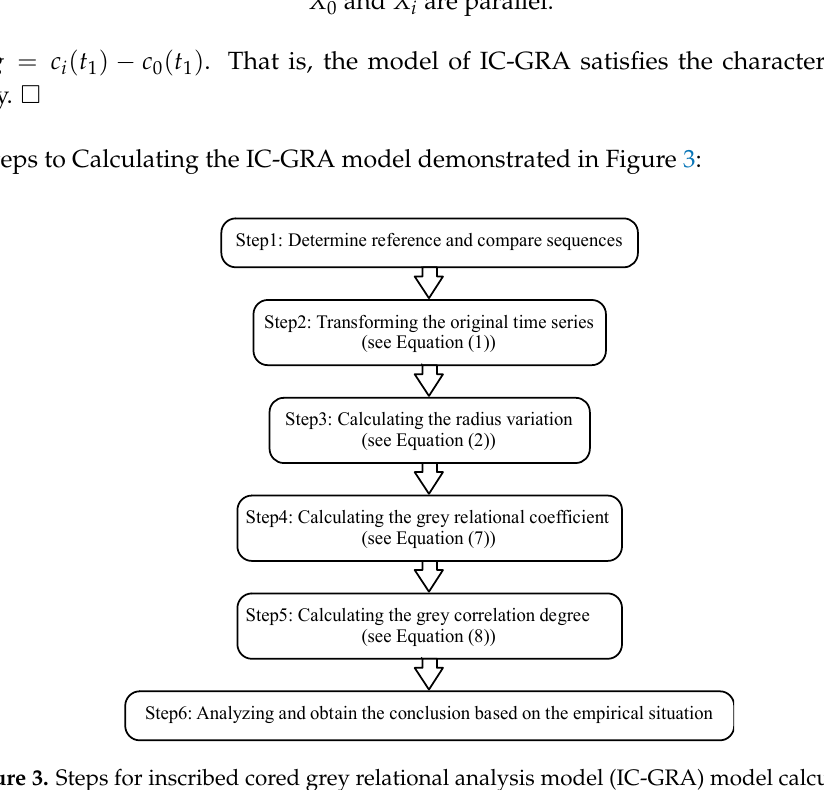
Figure 3. Steps for inscribed cored grey relational analysis model (IC-GRA) model calculations.